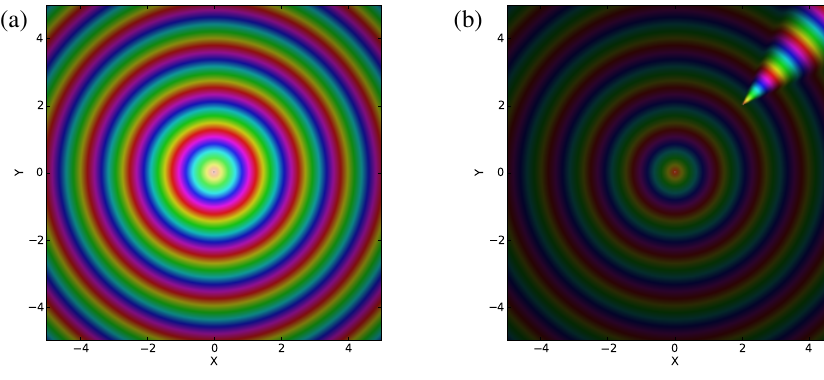
Figure 2. α -particle wave function (a) in the absence (b) in the presence of an obstacle. In case (b), only the elastic-scattering part of the wave function is represented and the wave function is assumed to have reached its first-order Born-approximation asymptotic behaviour everywhere. The phase of the wave functions is represented by the colour hue while their modulus is represented by the colour brightness